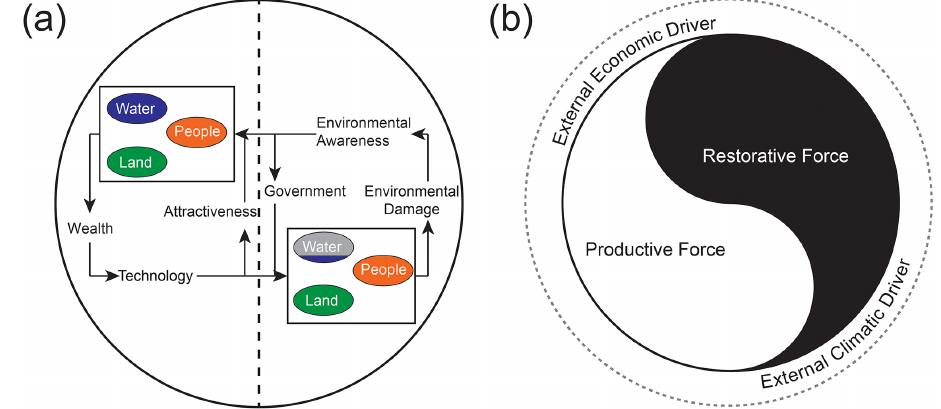
Figure 11. (a) Positive and negative feedback loops that are built into the model; (b) Taiji–Tire model representation of the dynamics